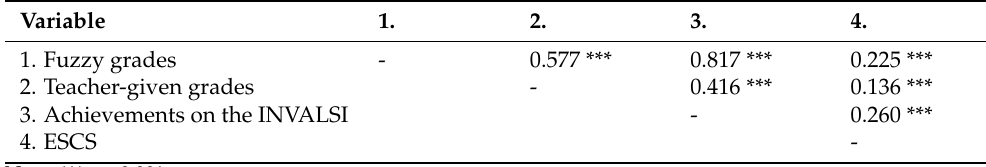
Table 6. Spearman’s correlation coefficients between the variables.